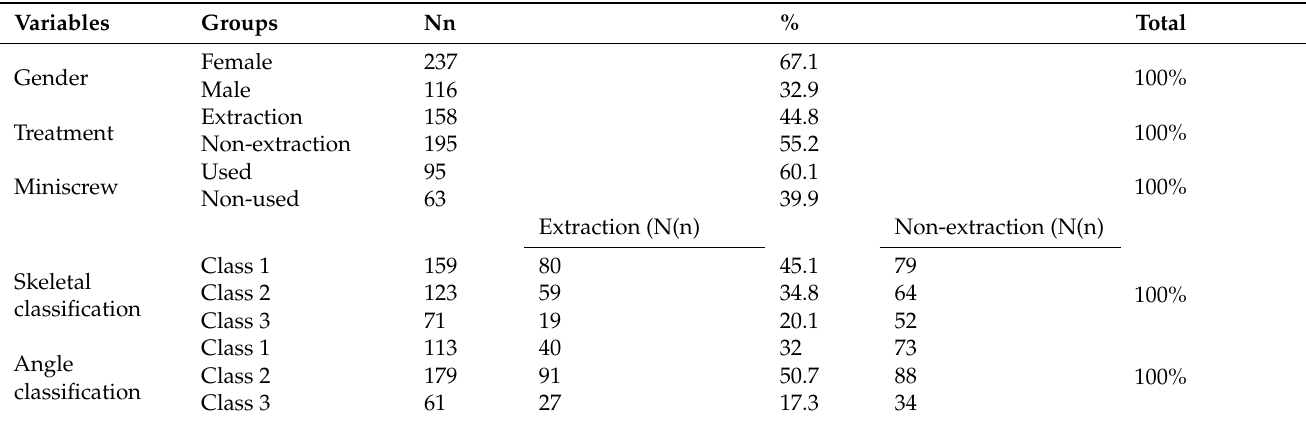
Table 1. Patients’ characteristics included in the study.